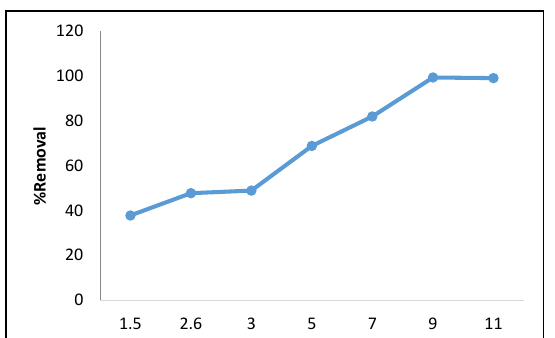
Fig. 7. The removal efficiency Ni (II) by ferrous sulfate at different pH values